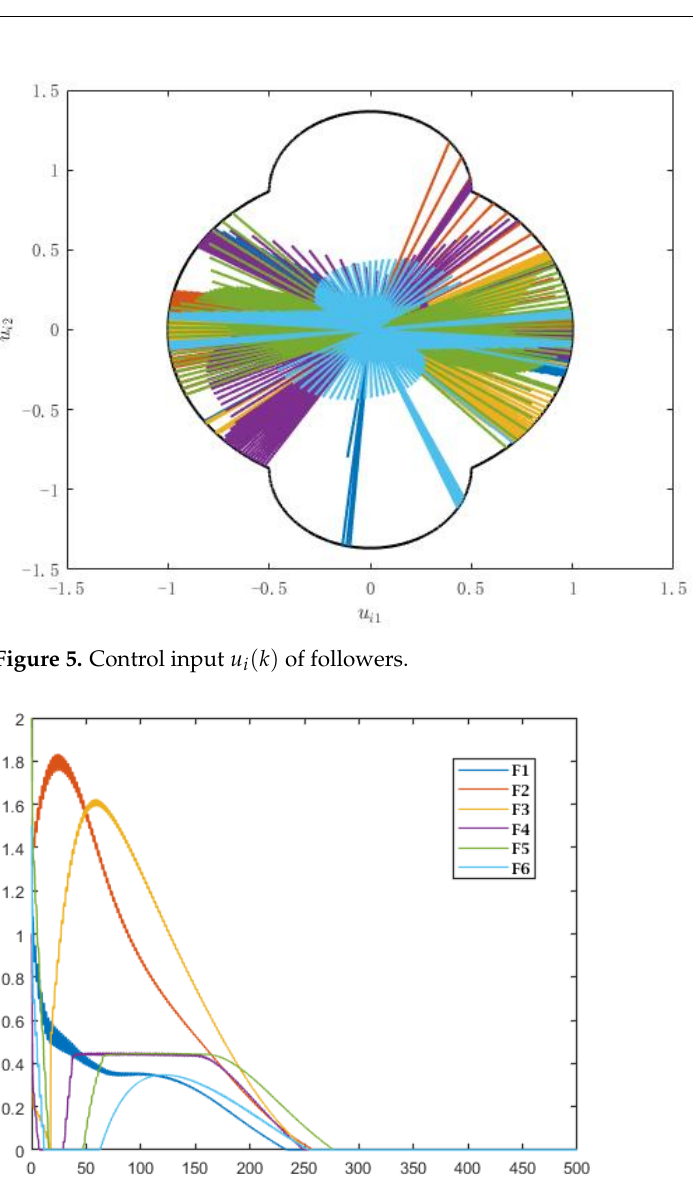
Figure 6. Containment errors of followers.